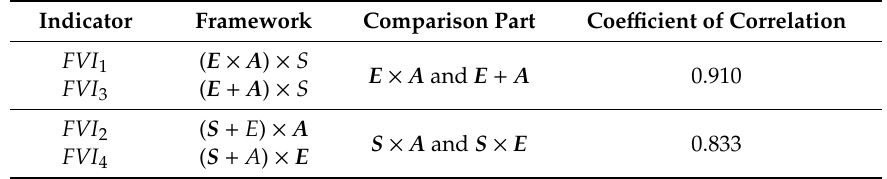
Table 4. The causality analysis of similarities between the two pairs of flood vulnerability indicators, FVI 1 and FVI 3 and FVI 2 and FVI 4 by the coe ffi cient of correlation for heterogeneous portions of each pair of flood vulnerability